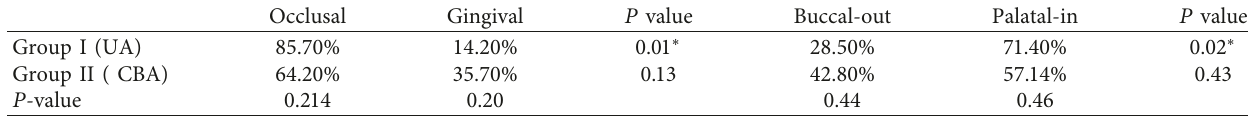
Table 2: Linear directional bias of orthodontic attachments ( Y and Z axes).